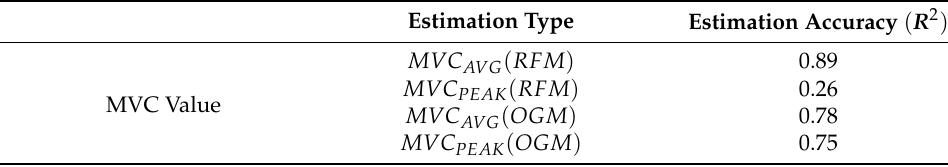
Table 5. The performance of the muscular activity